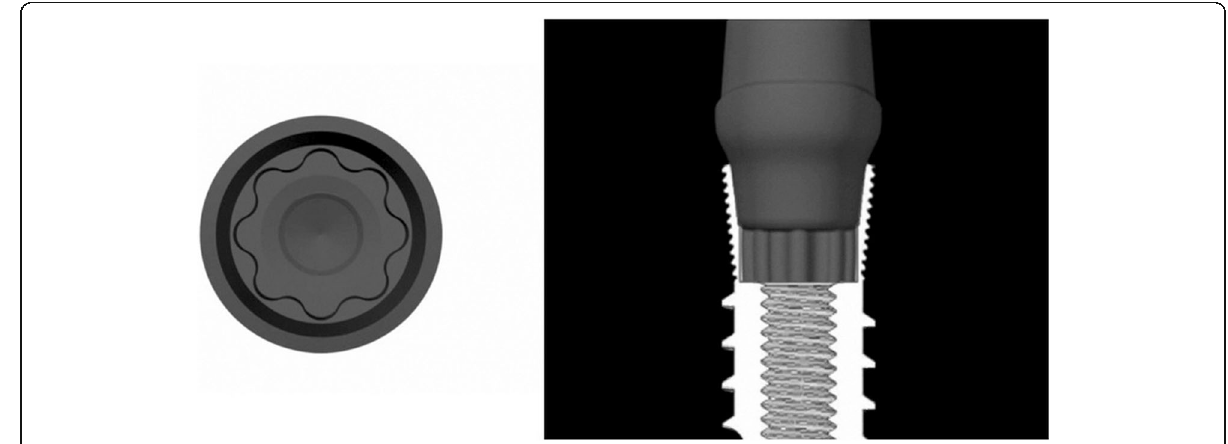
Fig. 1 Cone connection combined with octalobular index